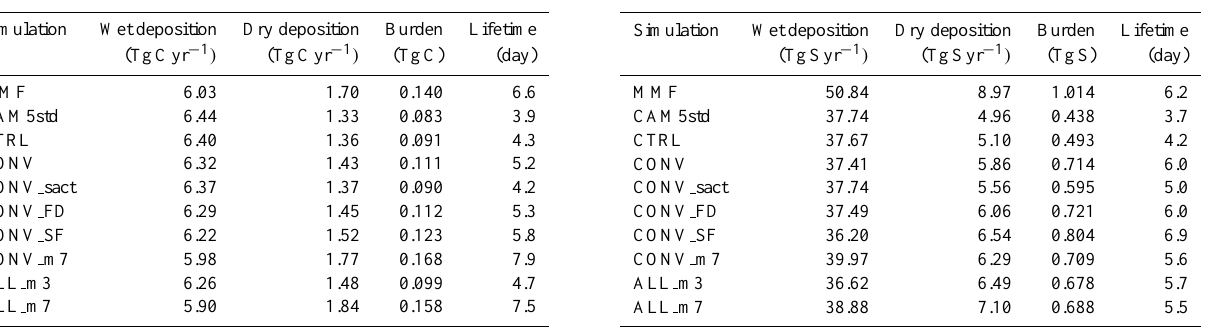
Table 2. Global annual BC budgets in MMF and CAM5 simula- tions.